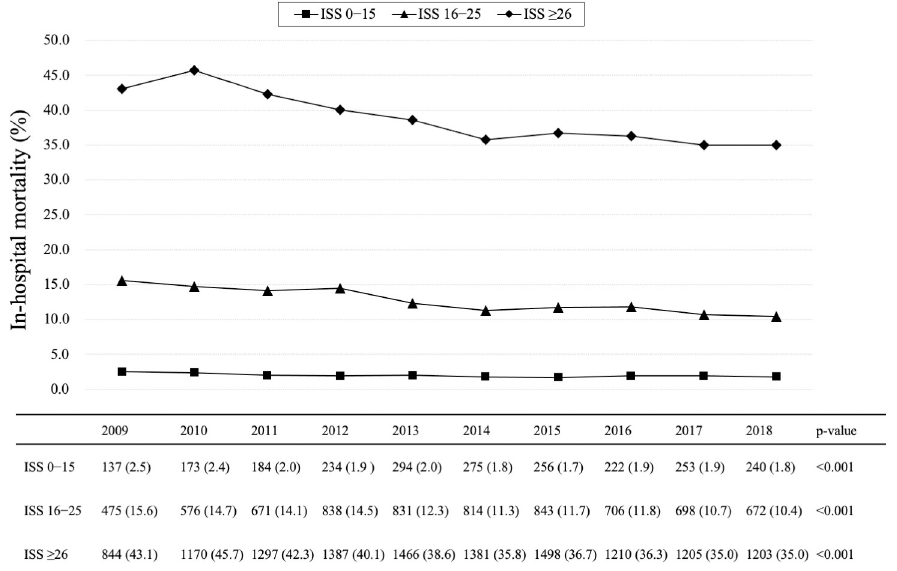
Fig 2. In-hospital mortality trends among injured patients according to ISS